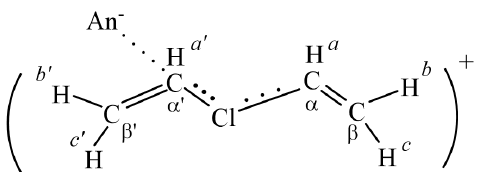
Figure 4. The 1 H NMR spectrum of the (C 2 H 3 ) 2 Cl + {Cl 11 − } salt dissolved in SO 2 ClF. The signals from the vinyl group that more strongly bonded with the Cl + atom are labeled with an asterisk. The sig ‐ nals from the decomposition products that grow with time are marked with the “ ♣ ” sign. Designa ‐ tions H a , H b and H c are given in the Scheme 2.